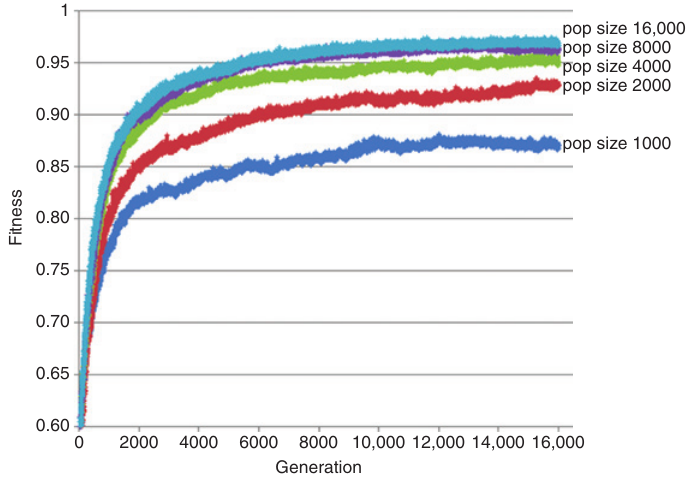
Figure 4: Effect of Population Size on Fitness, for Experiment